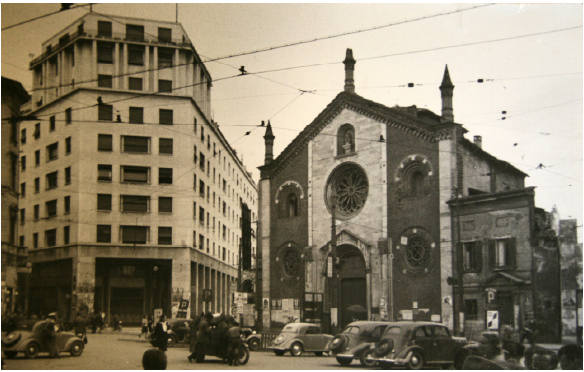
Figure 2. San Giovanni in Conca before